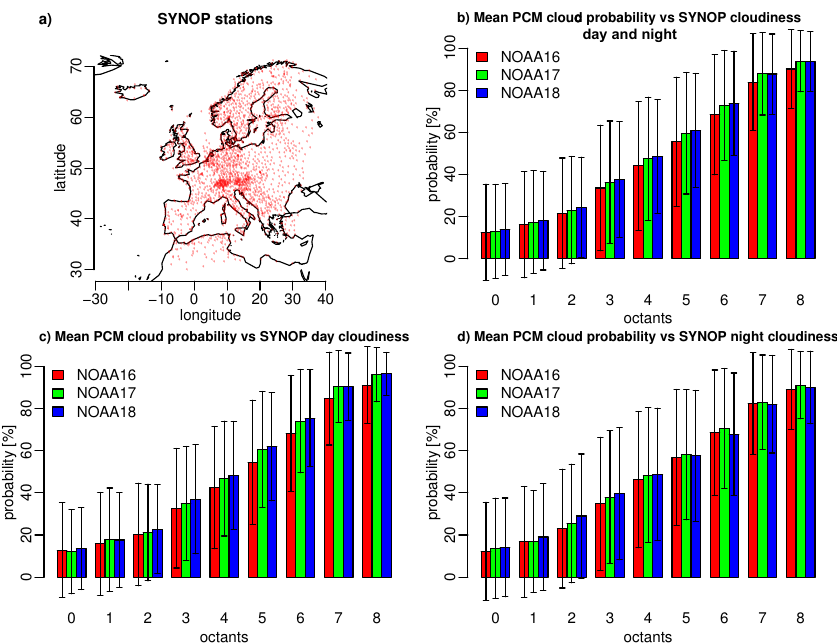
Fig. 16. (a) Geographic distribution of SYNOP stations. (b) – (d) Distribution of mean PCM cloud probability as a function of SYNOP cloud amount expressed in octants for different times of day. Error bars denote standard deviations. For details see Sect.